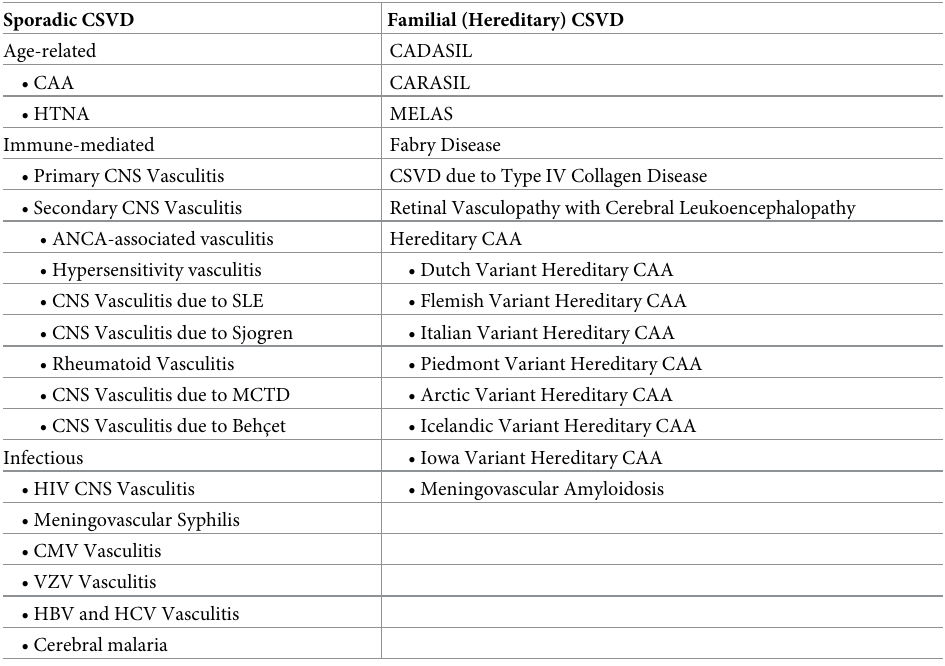
Table 1. Cerebral small vessel disease